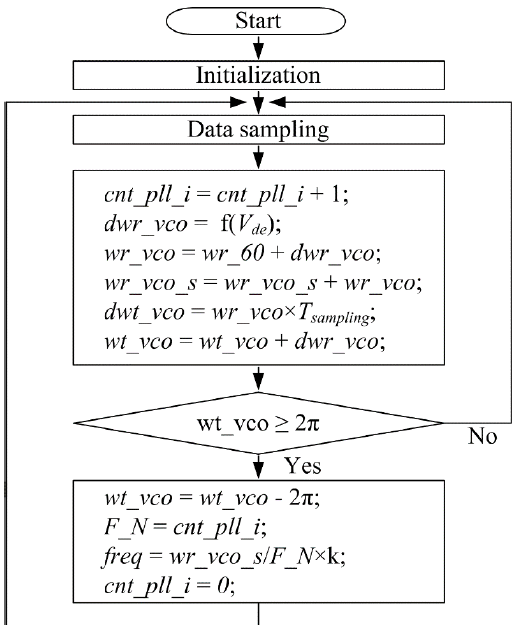
Figure 6. Flowchart of the proposed PLL technique to calculate the line frequency.